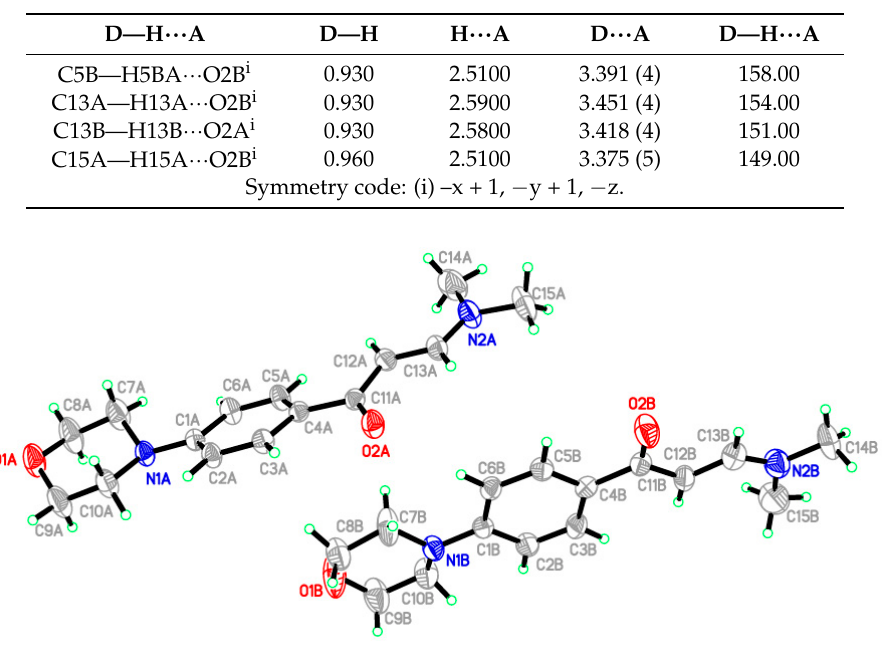
Figure 3. ORTEP diagram of the enaminone ( IIb ) containing morpholine moiety. Displacement ellipsoids are plotted at the 40% probability level for non-H atoms. Molecules 2018 , 23 , x FOR PEER REVIEW